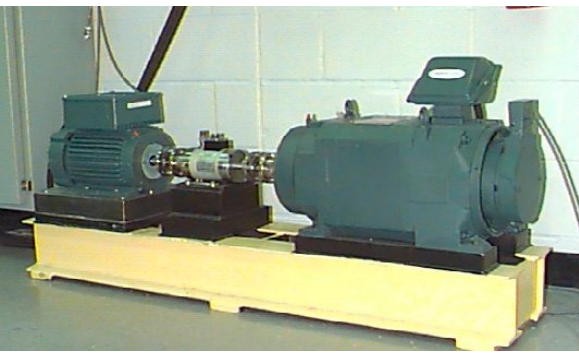
Figure 4. CWRU bearing fault test rig [42]. Table 1. Description of the rolling bearing dataset and sample partition.